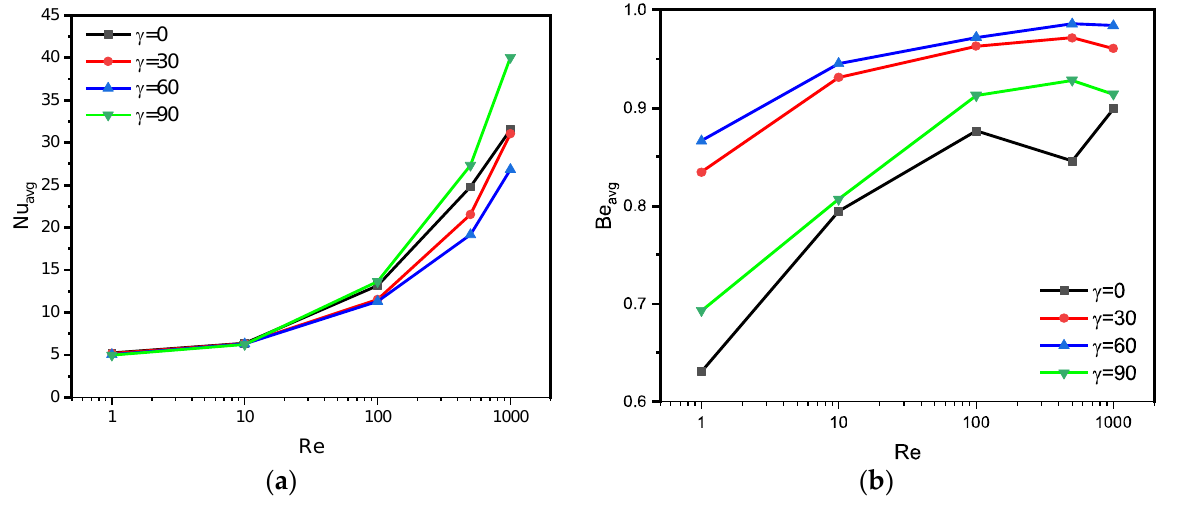
Figure 7. Effects of the elliptic-shaped inclination angle 𝛾 on the ( a ) average Nusselt number Nu avg and ( b ) average Bejan number Be avg at Ha = 0, and 𝑆𝑡𝑒 = 0.2.